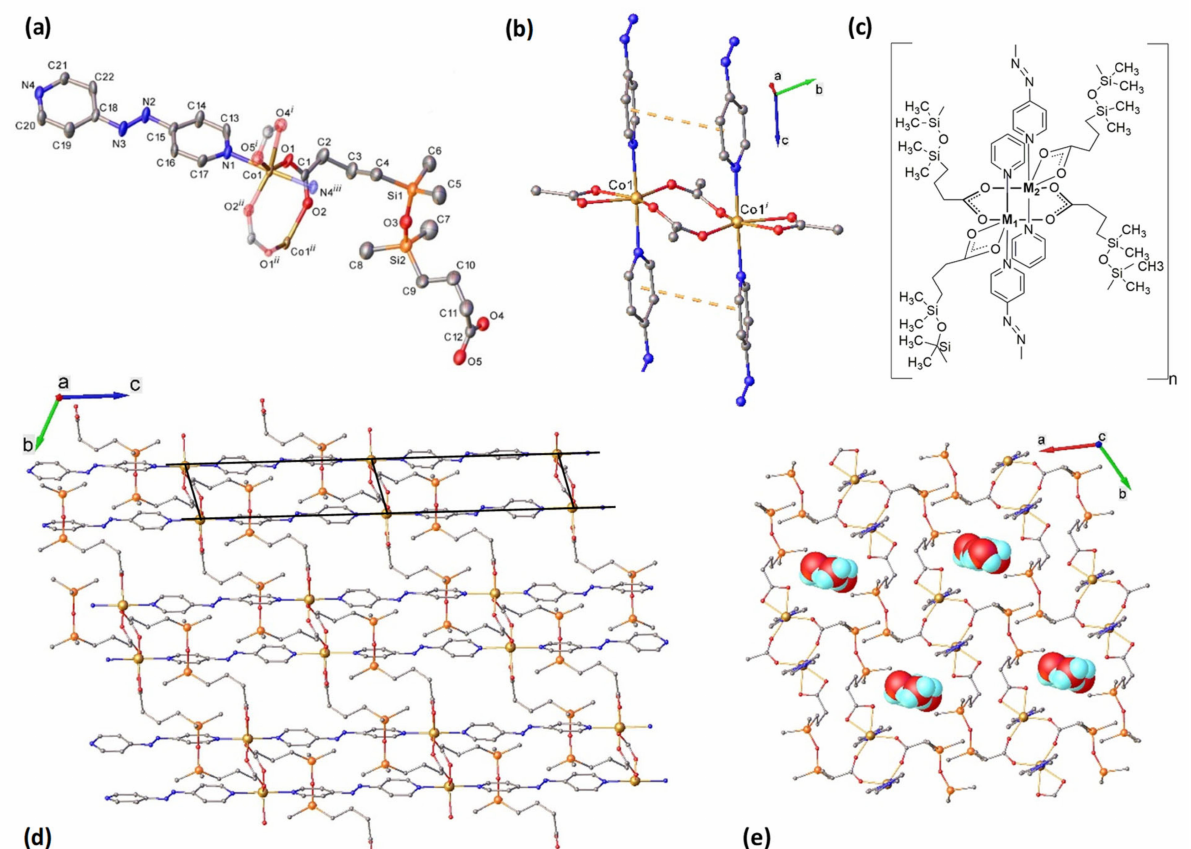
Figure 1. Structure of compound {[CoCxAPy)] · 2.15 H 2 O} n ( 1 ). ( a ) View of the asymmetric unit with atom labelling and thermal ellipsoids at 50% level. H atoms are omitted for clarity. Atoms obtained by symmetry-transformations are displayed semi-transparent. Symmetry codes: i) x , y − 1, z − 1; i) 1 − x , 1 − y , 1 − z ; i) x , y , 1 + z . ( b ) Co-Co dimeric unit conforming the ladder rungs. Centroid–to–centroid distance is of 4.0755(7) Å and slippage of 1.384 Å. ( c ) Line-drawing for dinuclear fragment: M1 = M2 = Co ( 1 ); M1 = Co; M2 = Zn ( 2 ); ( d ) Schematic representation of 2D-CP, formed by interconnection of the ladder-like structures running along the c -axis; ( e ) ab -plane view of the structure showing the pores where other molecules can be housed (e.g., water molecules in the